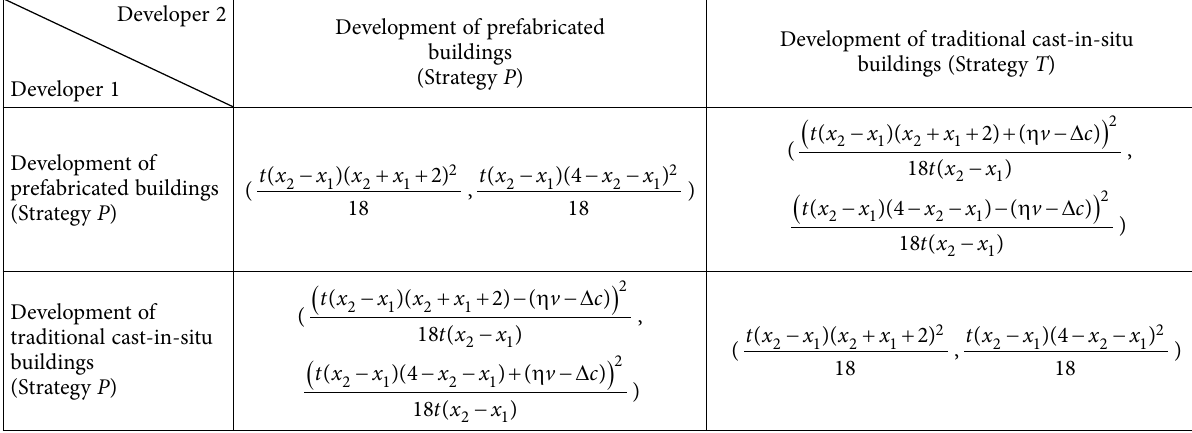
Table 3. Income matrix of Game 1 and 2 of construction developers under different strategy